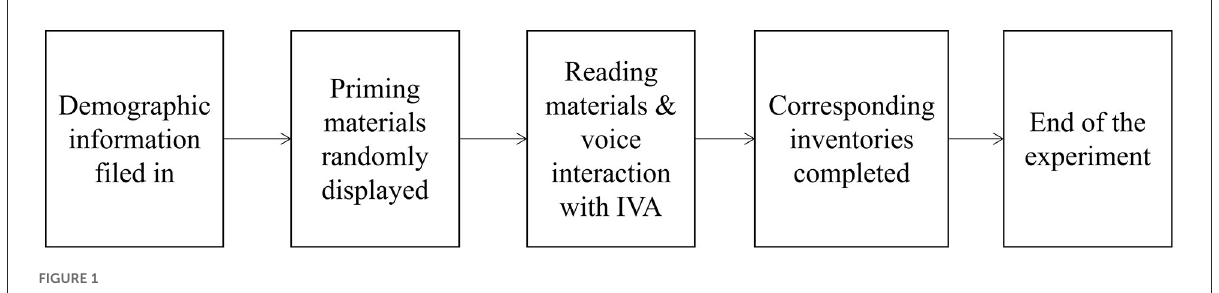
FIGURE1 Diagram for the experimental